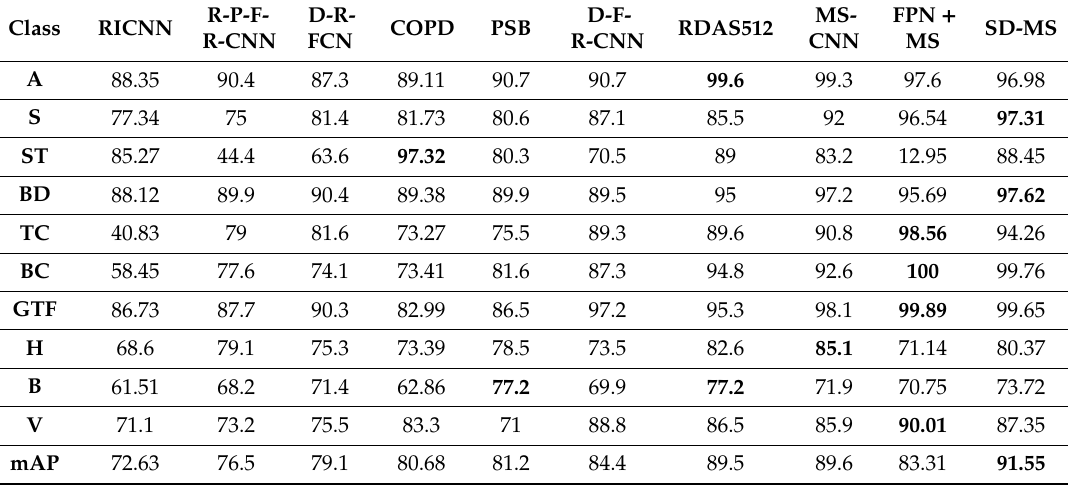
Table 4. The AP values of eight object detections are compared with the two models, feature pyramid networks with multi-scale anchor (FPN+MS) and shallow-deep feature extraction with multi-scale anchor (SD-MS).